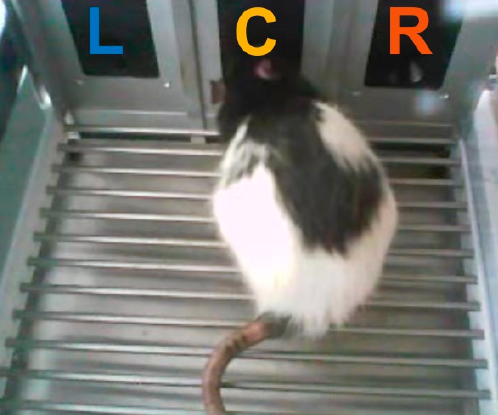
Figure 1. Picture of the operant chamber with a rat poking into the center (reward) port. Reward (30 µL of water) could be triggered by poking into the left (L) and right (R) ports at random intervals. Water reward is delivered at the center (C) port. The stainless steel grid floor was used to deliver mild foot shocks in later experiments.